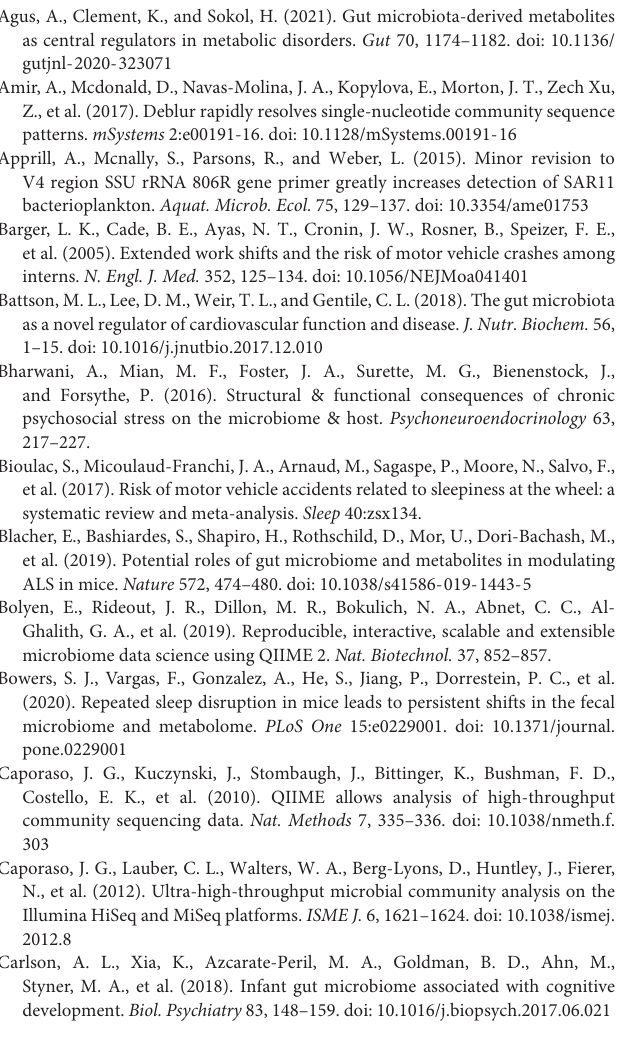
on the 16S rRNA gene microbiome data to predict genetic content. DESEq2 was then performed at each timepoint to identify predicted pathways that were differentially abundant due to diet. The above reports the pathway ID, description, fold change, and direction of change of the 8 pathways that were significantly altered by diet at T2, T3, and T4. Supplementary Figure 3 | The Prebiotic Diet Does Not Prevent Sleep Disruption-Induced Changes in Body Weight. Animals were weighed throughout the experiment. Day 0 indicates the start of baseline sleep recording. Results of linear mixed effect modeling investigating overall effects and interactions with time are depicted above. Data represent mean + SEM. n = 9–12/group. Supplementary Figure 4 | The Prebiotic Diet Prevents Social Defeat-Induced Loss of Object Location Memory. Immediately after the end of the last sleep disruption period, half of the rats were exposed to 1 h of social defeat while the other half were exposed to a clean cage for an equivalent time period. Twenty-four hours later, object location memory was assessed in all rats. Location indices above 50% indicate retained contextual memory and learning. Data